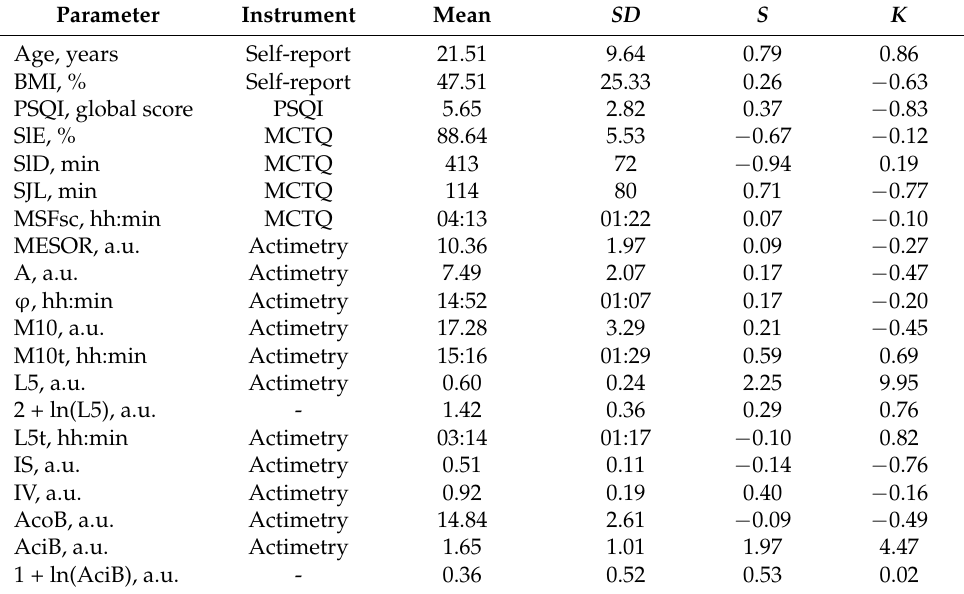
Table 1. Descriptive statistics parameters